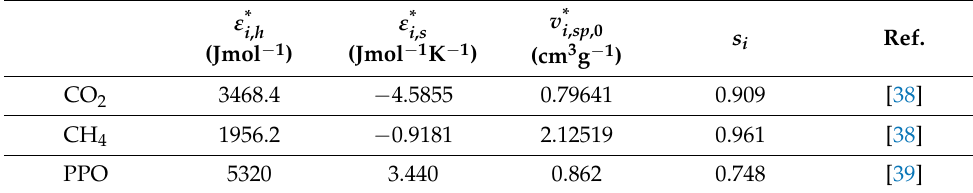
Table 1. NR lattice fluid